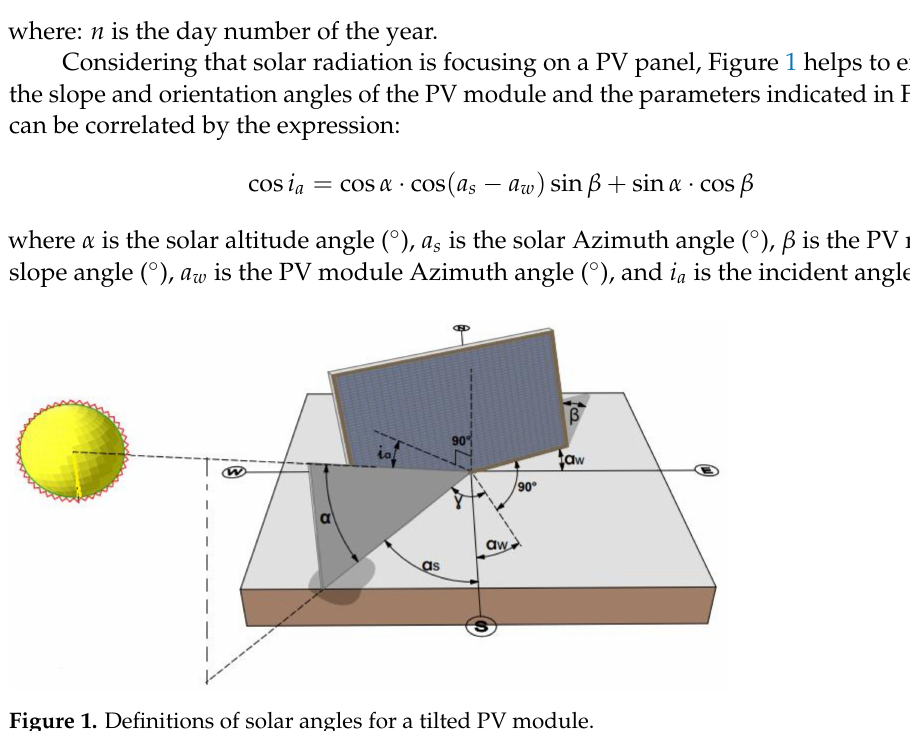
Figure 1. Definitions of solar angles for a tilted PV